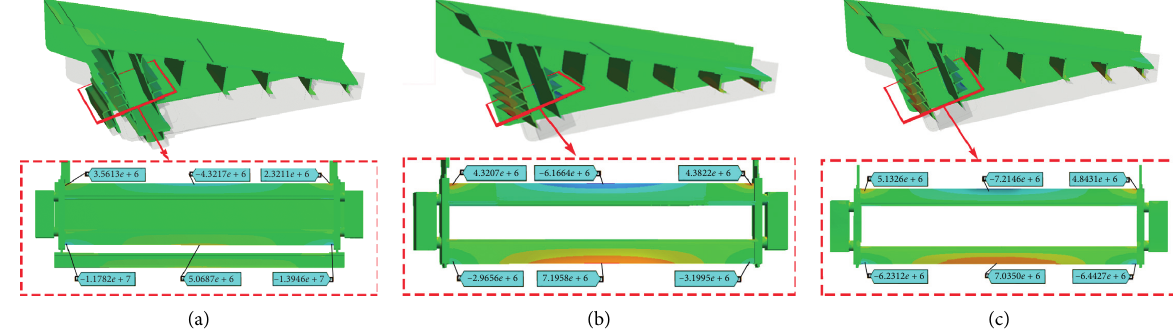
Figure 12: Stress cloud diagram of the beam of vibrating feeder after optimization. (a) Scheme 1; (b) Scheme 2; (c) Scheme 3.